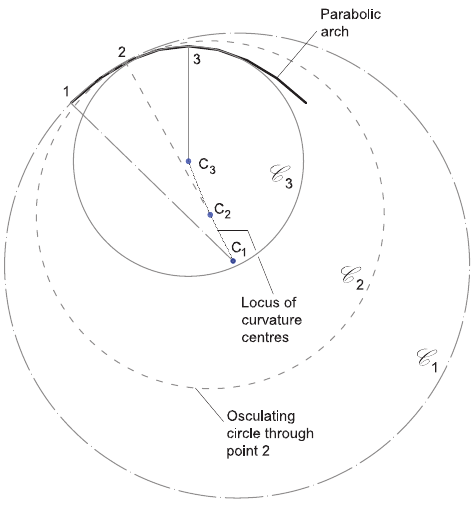
Figure 2: Parabolic arch, osculating circles C 1 , C 2 , C 3 and corre- sponding curvature centres C 1 , C 2 , C 3 .